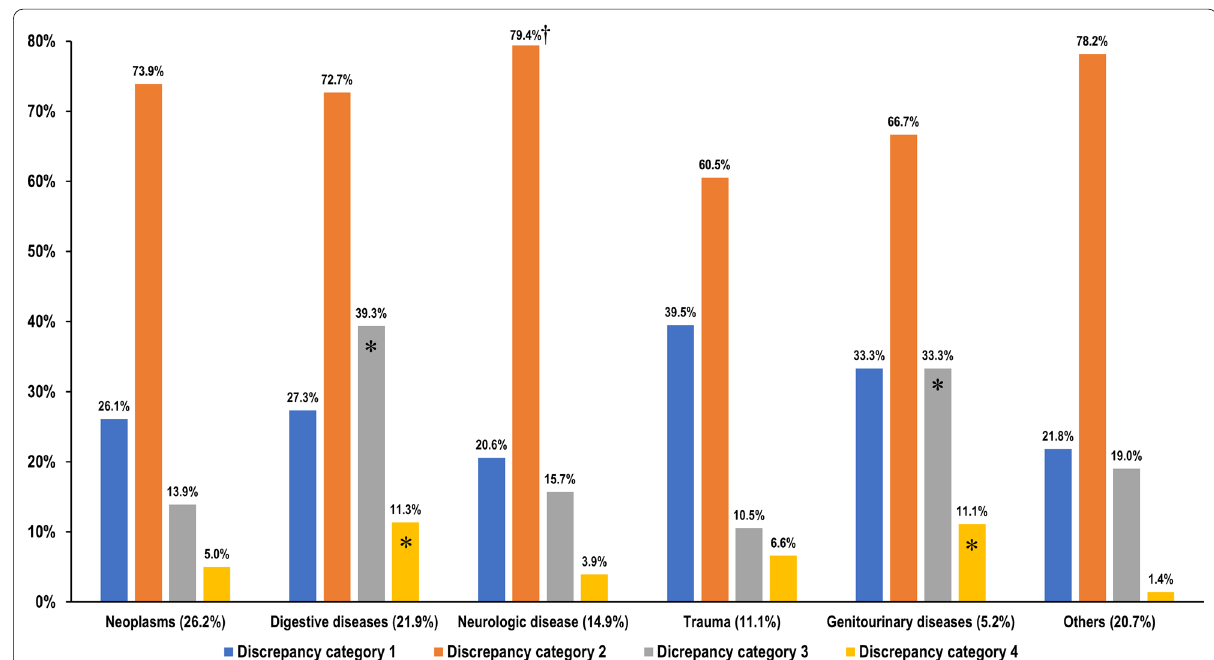
Fig. 2 Incidence of discrepancy categories according to disease category. *Each of discrepancy category 3 (inpatient management) and category 4 (adverse outcomes) occurred most frequently in association with digestive diseases, followed by genitourinary diseases. † Neurologic diseases were associated with the highest emergency department revisit rate